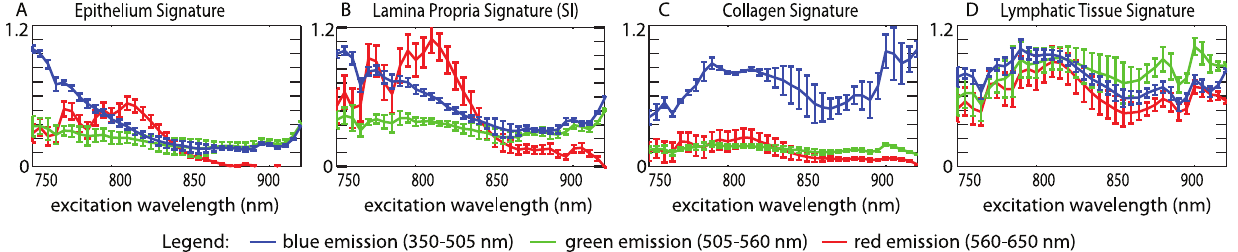
Figure 3. Mean spectral signatures extracted from four tissue types, after spectral calibration via normalization by in-vitro FAD spectra. Error bars are one standard deviation above and below each data point. (A) Epithelium: n=6 (4 mice, 6 sites) (B) Lamina propria: n=3 (2 mice, 3 sites) Lamina propria signatures were all taken from samples in the small intestine to minimize collagen overlap. (C) Collagen: n=4 (2 mice 4 sites) (D) Lymphatic tissue: n=4 (2 mice 4